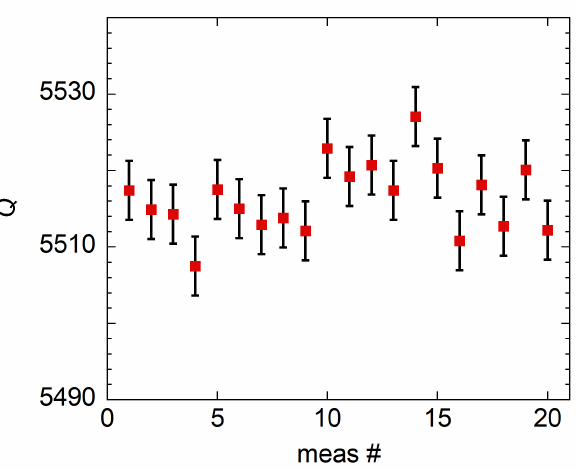
Figure 3. Mounting repeatability of the Q -factor measurement. The uncertainty bars represent the fitting uncertainties u ( Q ) / Q ∼ 10 − 4